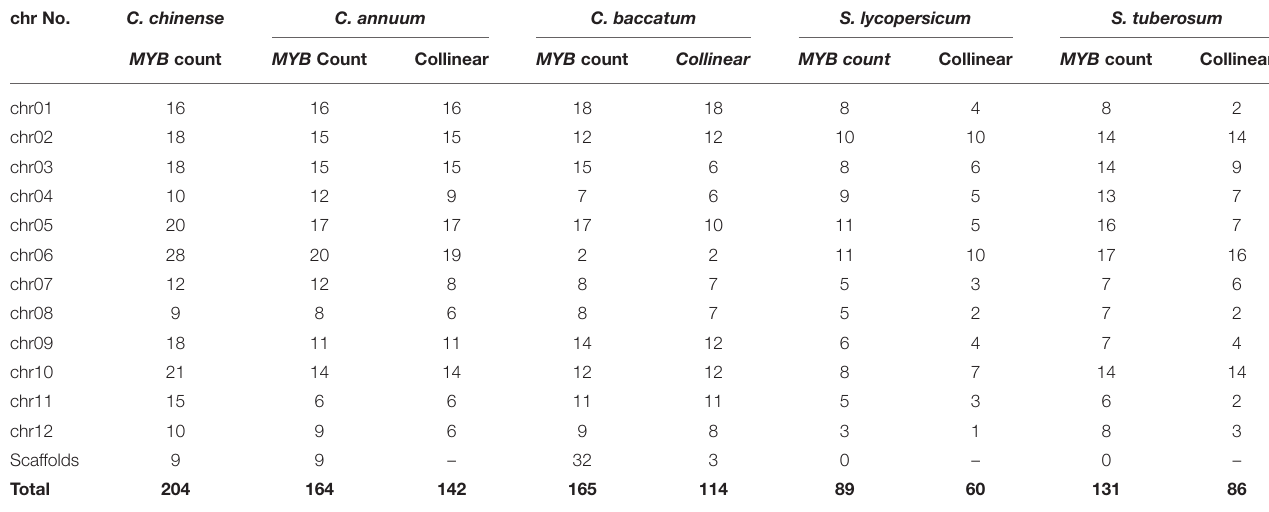
TABLE 3 | Chromosome-wise distribution and the number of collinear CcMYB genes on the same chromosomes as C. chinense in Solanaceae members. chr